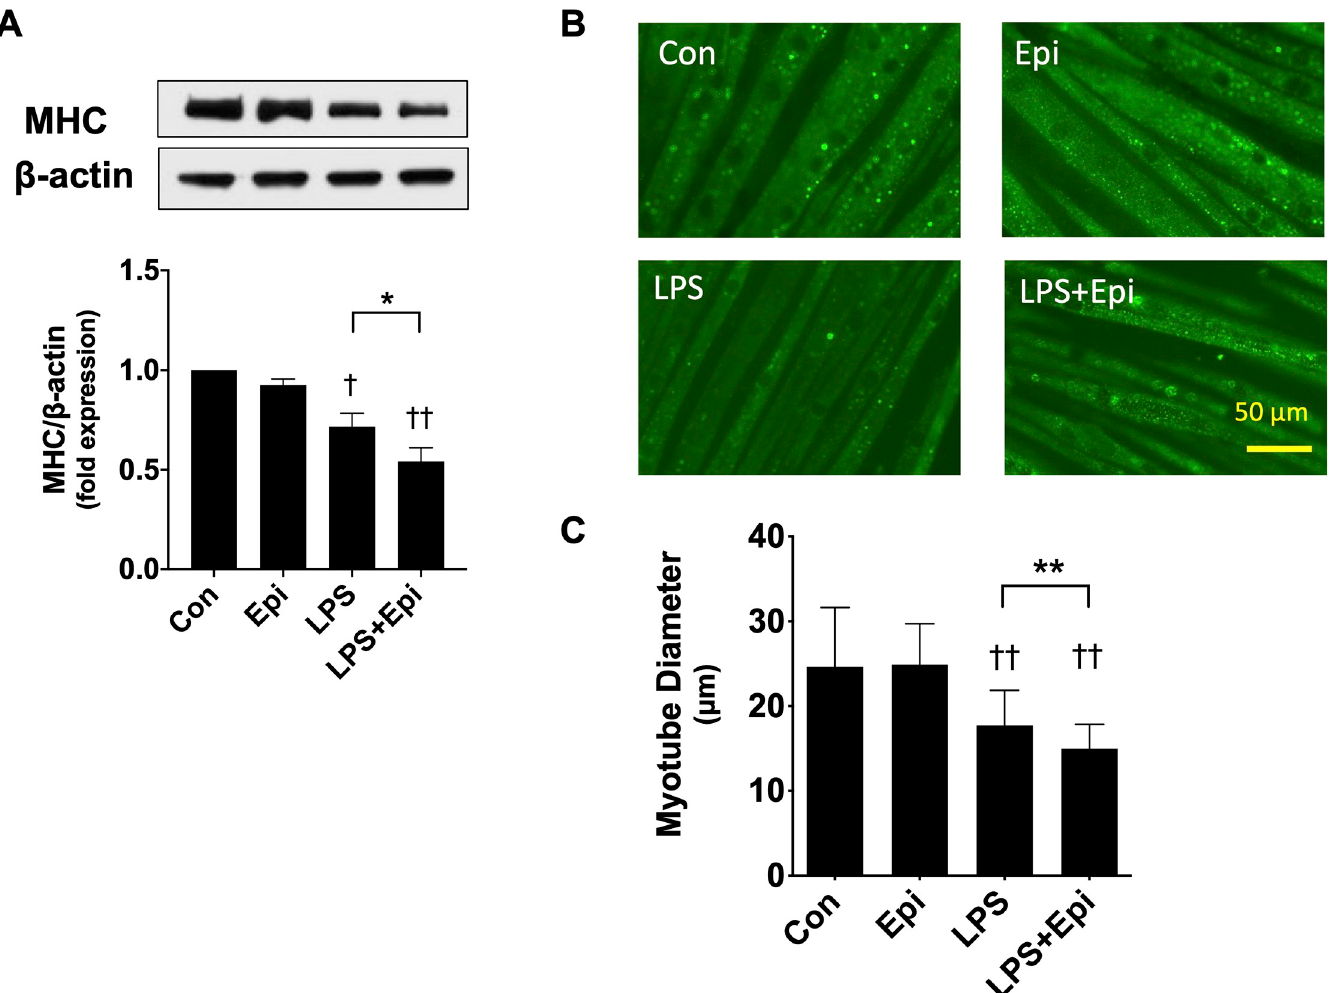
Fig 1. Epinephrine (Epi) exacerbated lipopolysaccharide (LPS)-induced myotube wasting in C2C12 myotubes. C2C12 myotubes were exposed to Epi (1 μ M) and/or LPS (50 ng/ml) for 24 h. (A) Whole-cell lysates were analyzed for myosin heavy chain (MHC) and β -actin protein expression with immunoblotting assays. Representative immunoblots are shown (upper panel), and MHC protein expression quantified by densitometric analysis is shown as mean ± SEM (n = 5) of fold induction relative to the value of untreated control cells (lower panel). (B, C) Cells were immunostained with an MHC-specific antibody. Representative images (B), and myotube diameters measured from microscopic photographs (C) are shown. (†P < 0.05 and ††P < 0.005 compared with control, � P < 0.05 and �� P < 0.005 for comparisons between the indicated groups).